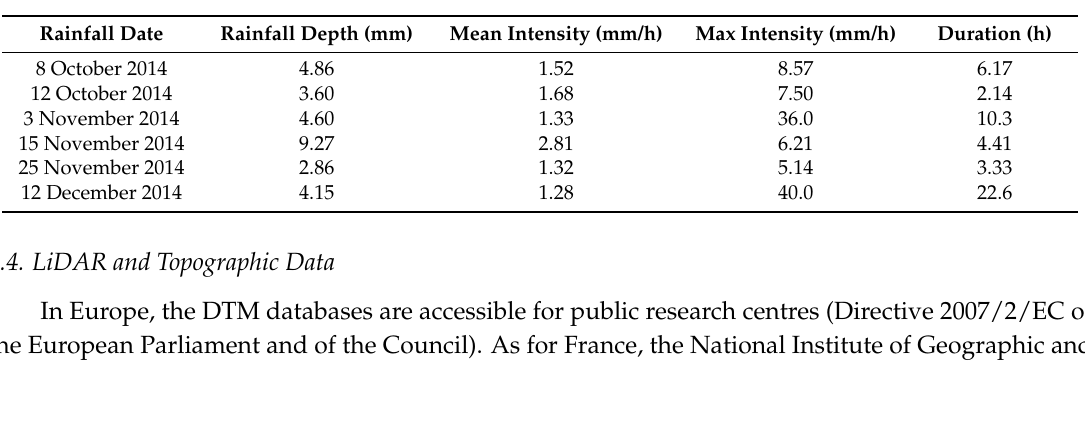
Table 1. Characteristics of the six studied rainfall events.